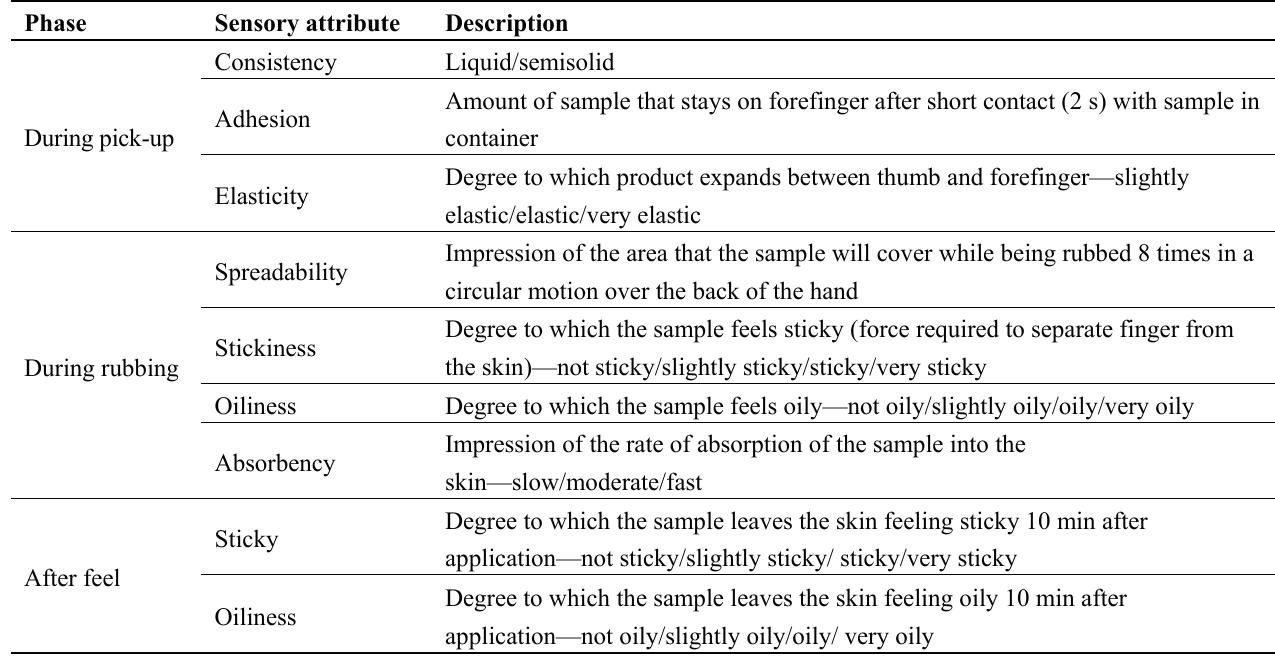
Table 2. Description of attributes used for sensory